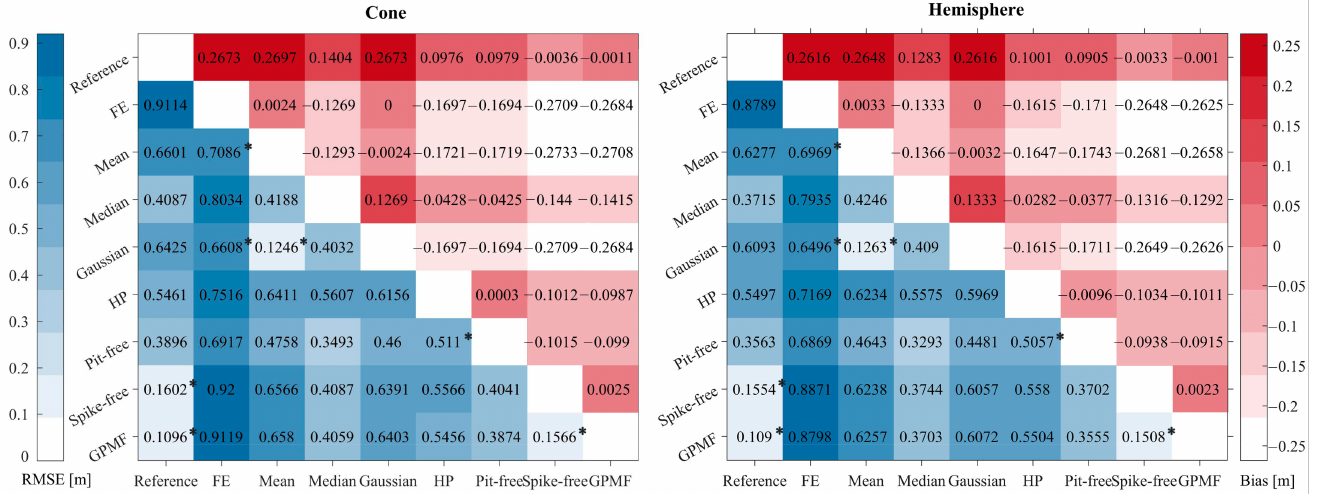
Figure 5. Differences across all the CHMs generated by the simulated point cloud. The lower left corner of the matrix is the RMSE, and the upper right corner of the matrix is the Bias. The asterisk indicates that the t -test was not significantly